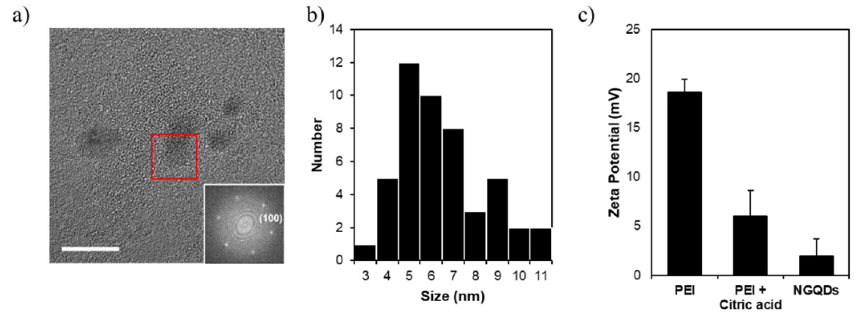
Figure 1. ( a ) TEM images of NGQDs (scale bar = 20 nm). ( b ) Size distribution of NGQDs. ( c ) zeta potentials of PEI, PEI + citric acid and NGQDs.